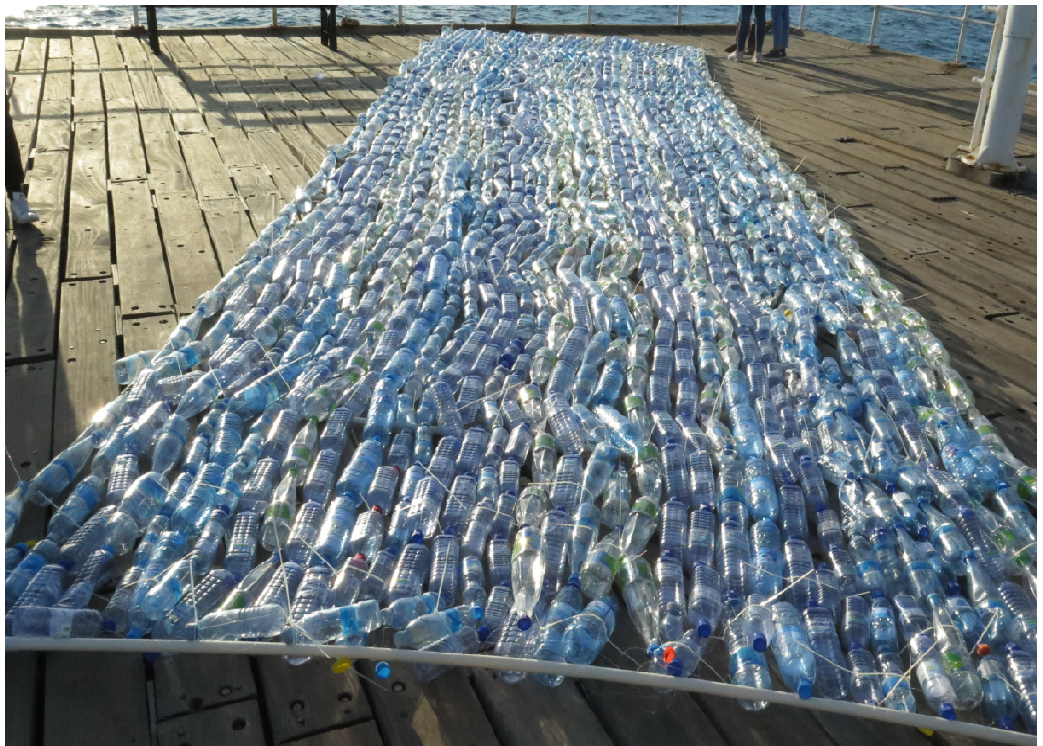
Figure 1. Plastic litter ‘target’ made from water bottles. Kyriacos Themistocleous.